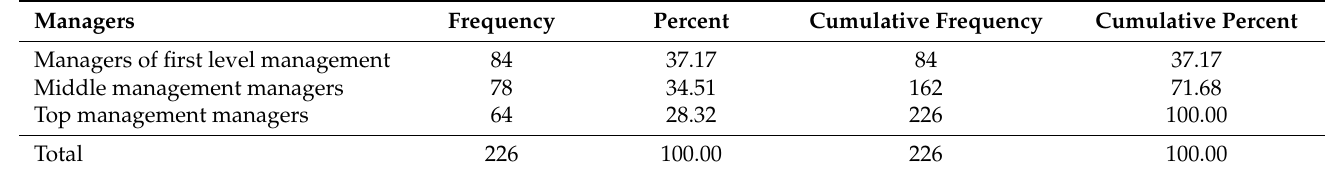
Table 1. Distribution of public administration managers by position in the